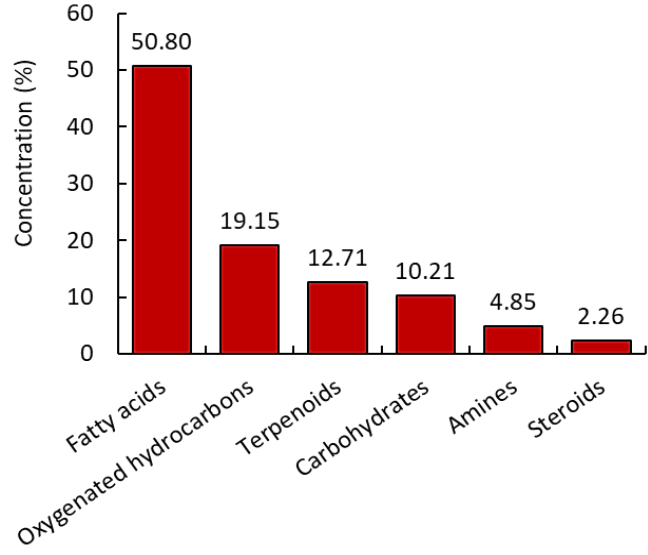
Figure 4. Various classes of the characterized chemical compounds of M. longipetala extract derived via GC-MS analysis.